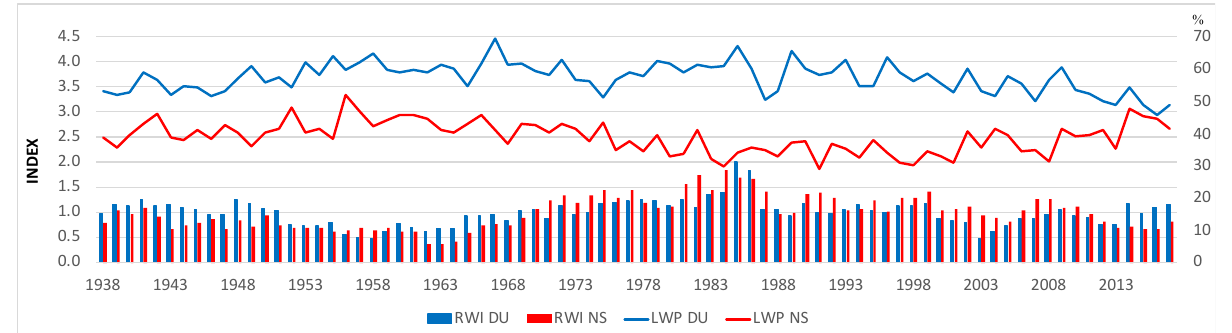
Figure 3. Variation of the ring width index (RWI) and latewood percentage (LWP) of Douglas fir (DU) and Norway spruce (NS) in FGR 2.